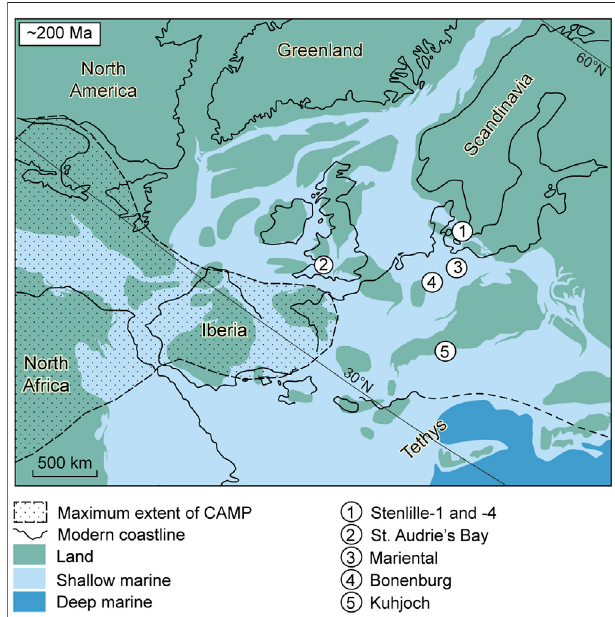
FIGURE1| Palaeogeographicmap (afterBlakey, 2014)oftheEuropean epicontinentalseaandthenorthernTethysmargin,showingthelocationofthe studiedcoredwellsStenlille-1and-4,andotherlocalitiescomparedwithinthe text.